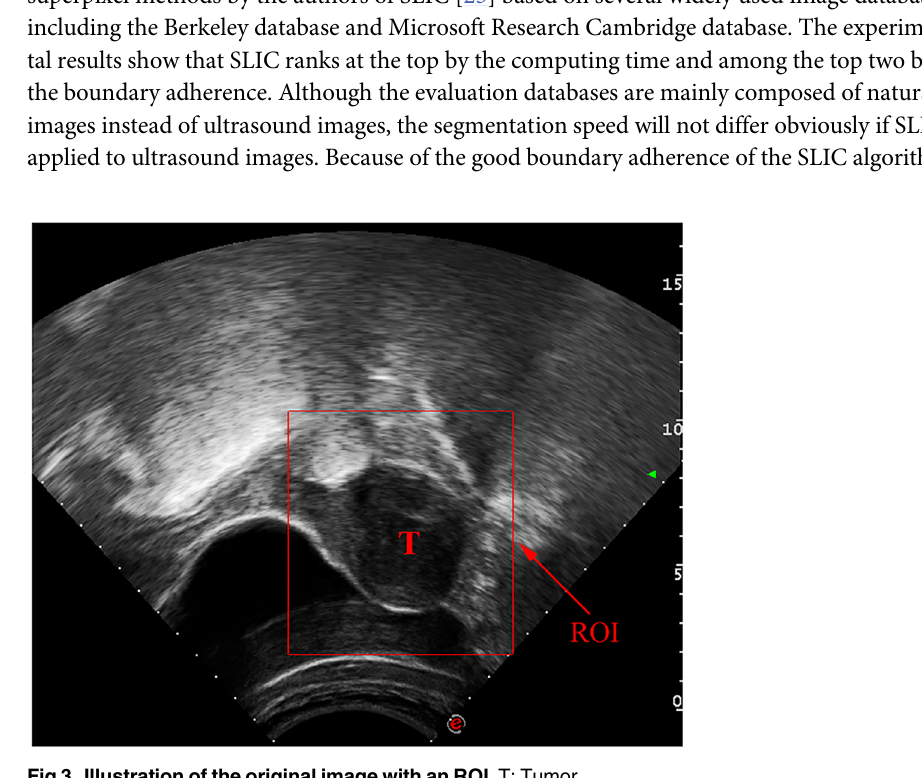
Fig 3. Illustration of the original image with an ROI. T: